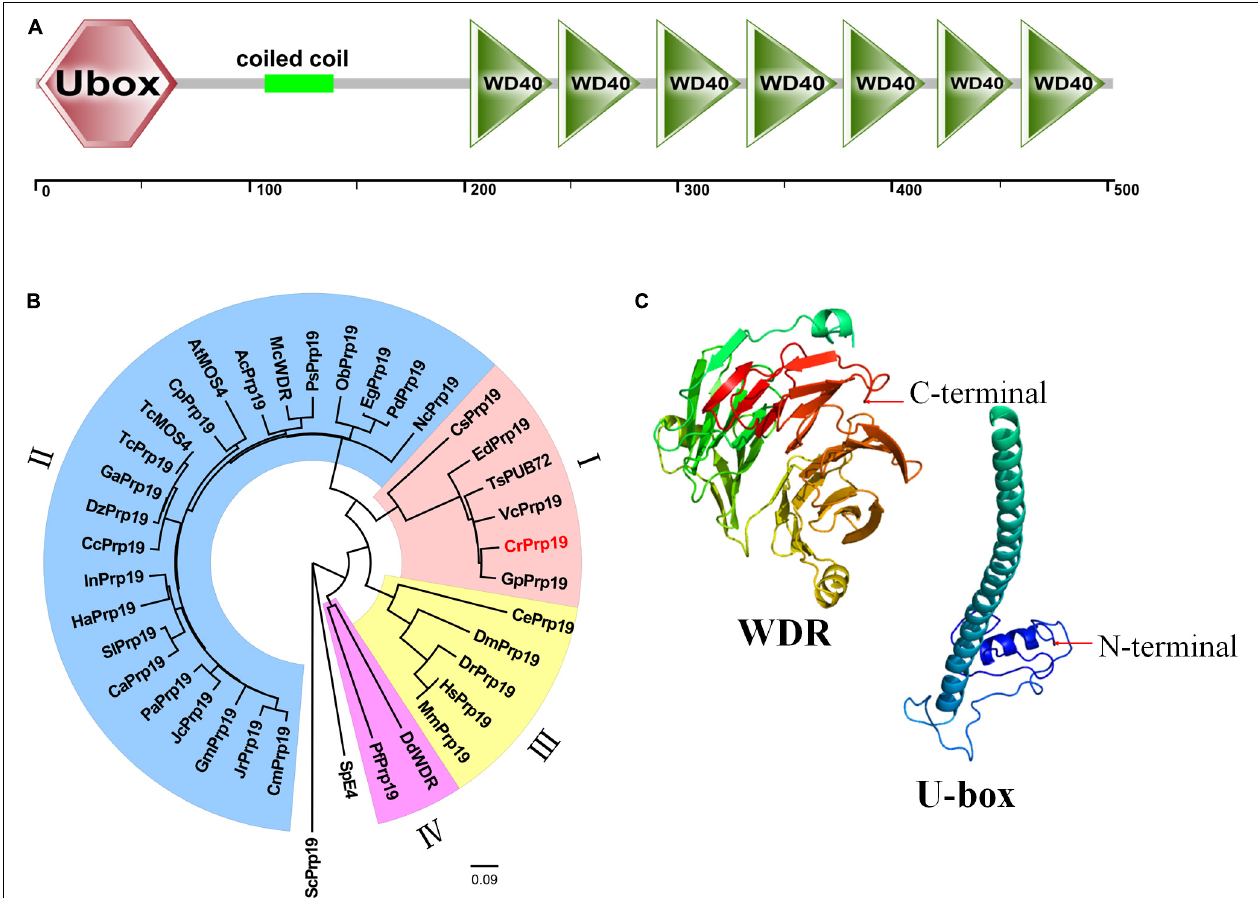
FIGURE 1 | Features of CrPrp19 protein. (A) Scheme shows the domains of CrPrp19 protein. (B) NJ phylogenetic tree of CrPrp19 protein. The tree was constructed with the Mega7.0 with amino acid sequences of CrPrp19 homologous proteins retrieved by BLASTp searching in NCBI (GenBank accession numbers are listed in Supplementary Table 2 ). (C) Three-dimensional structure of U-box and WDR domain of